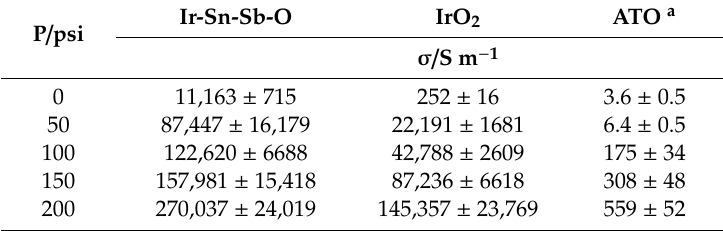
Table 1. Electrical conductivity of the synthesized materials at di ff erent pressures